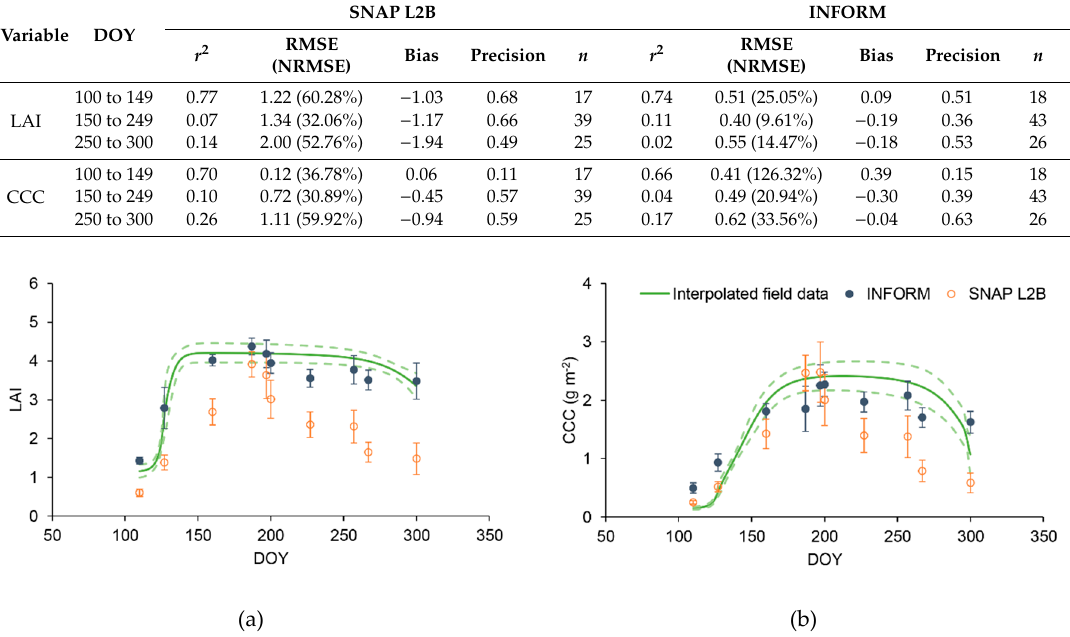
Figure 5. Time series of mean LAI ( a ) and CCC ( b ) retrievals calculated over all ESUs. Error bars and dashed lines represent ± 1 standard deviation.